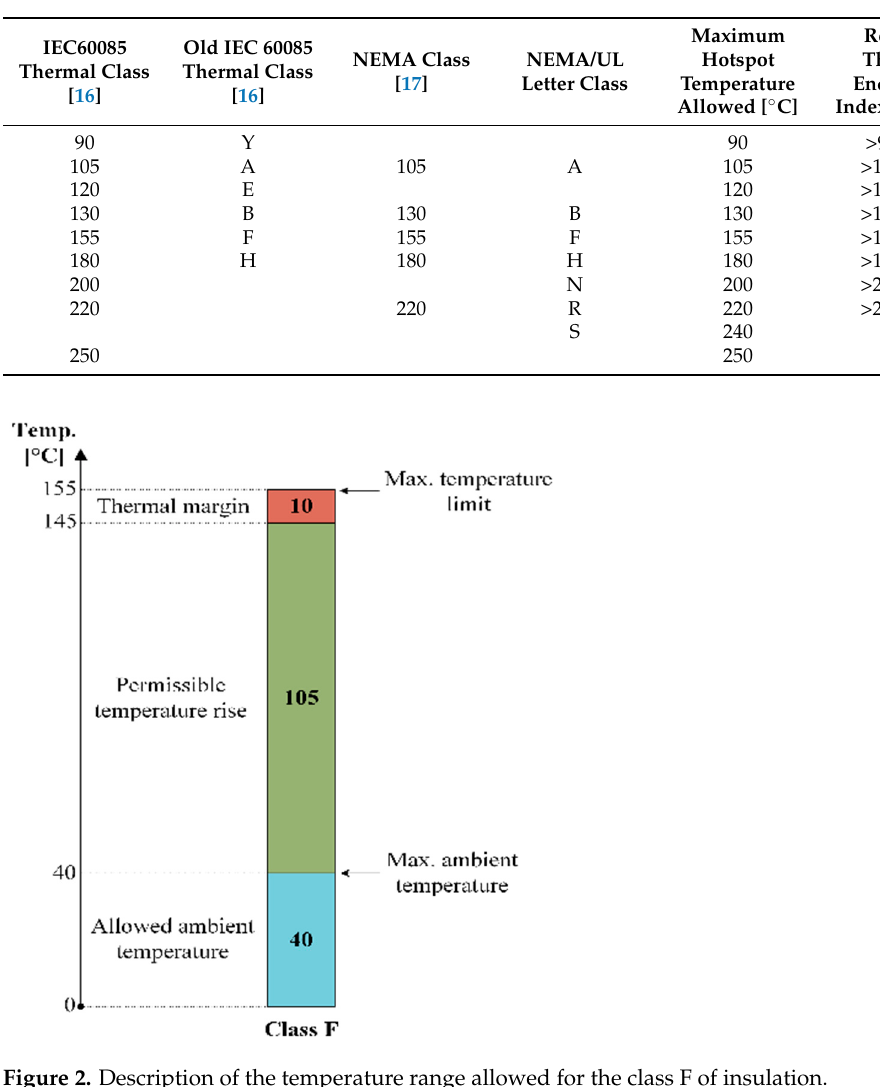
Table 1. Insulation system classes, according to the NEMA and IEC 60085 classification [15,16].